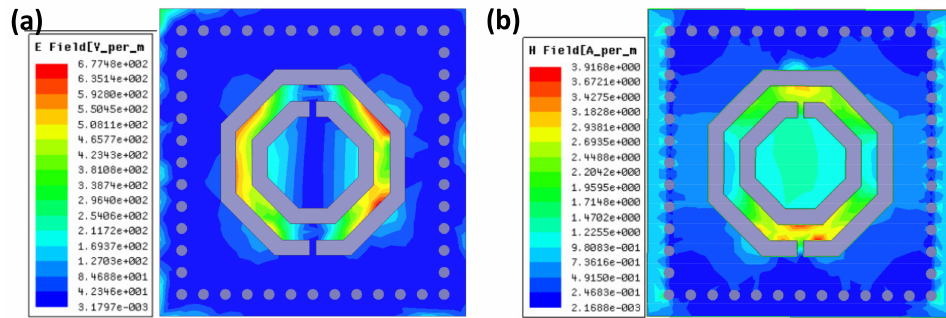
Figure 4. ( a ) Electric field distribution. ( b ) Magnetic field distribution.